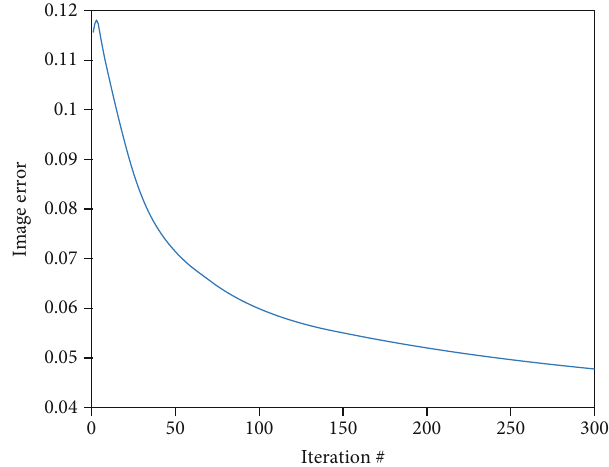
Figure 13: Image error for the objects shown in Figure